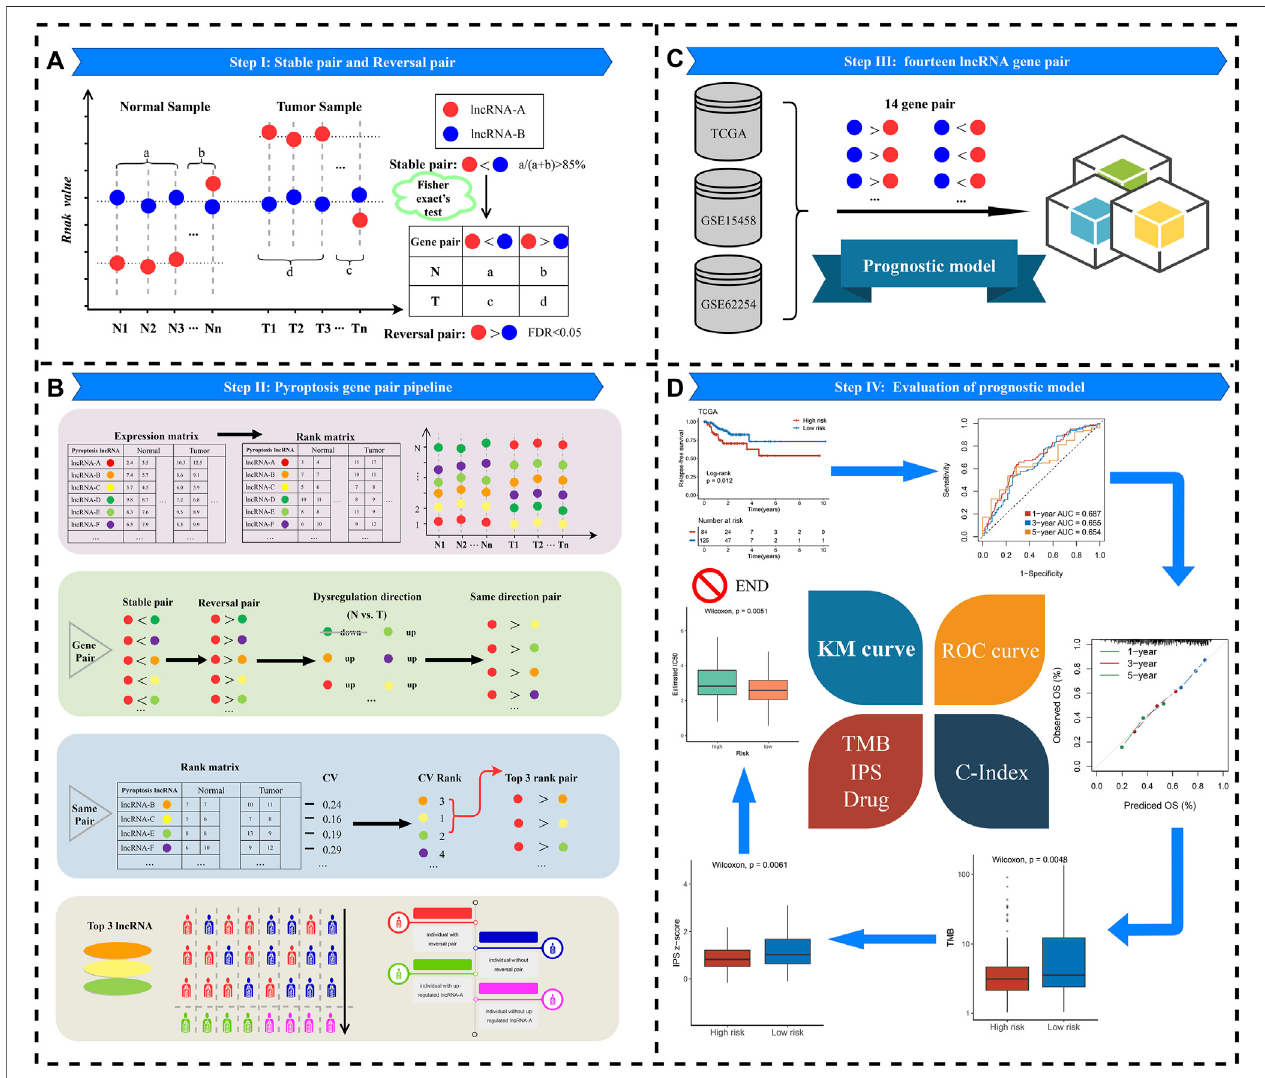
FIGURE 1 | Flowchart of analysis